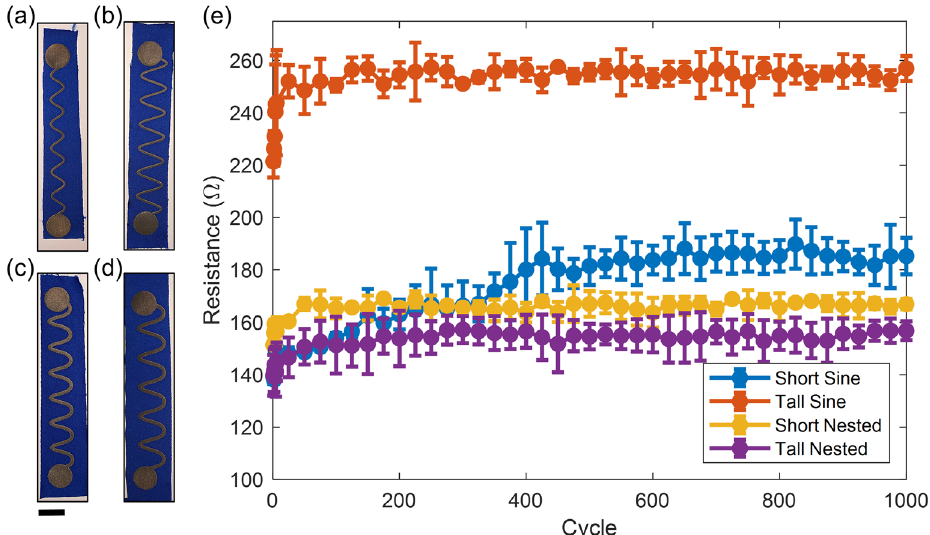
Figure 3. Strain cycling results showing the ( a ) short sine interconnect design, ( b ) tall sine interconnect design, ( c ) short nested interconnect design, and ( d ) tall nested interconnect design. Scale bar represents 2 cm. ( e ) Resistance versus cycle number at 25% strain over 1000 cycles (n = 3